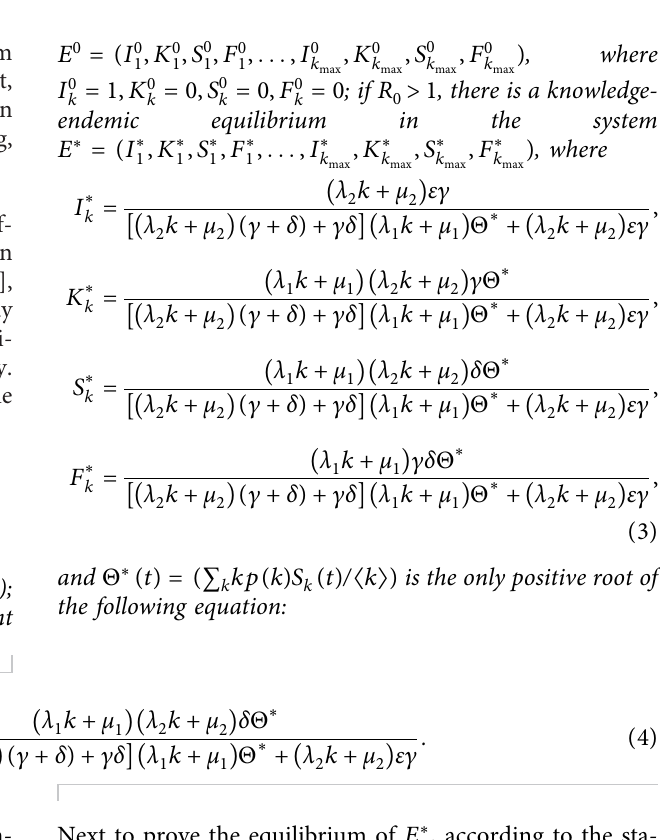
Figure 1: Structure of the IKSF knowledge transmission